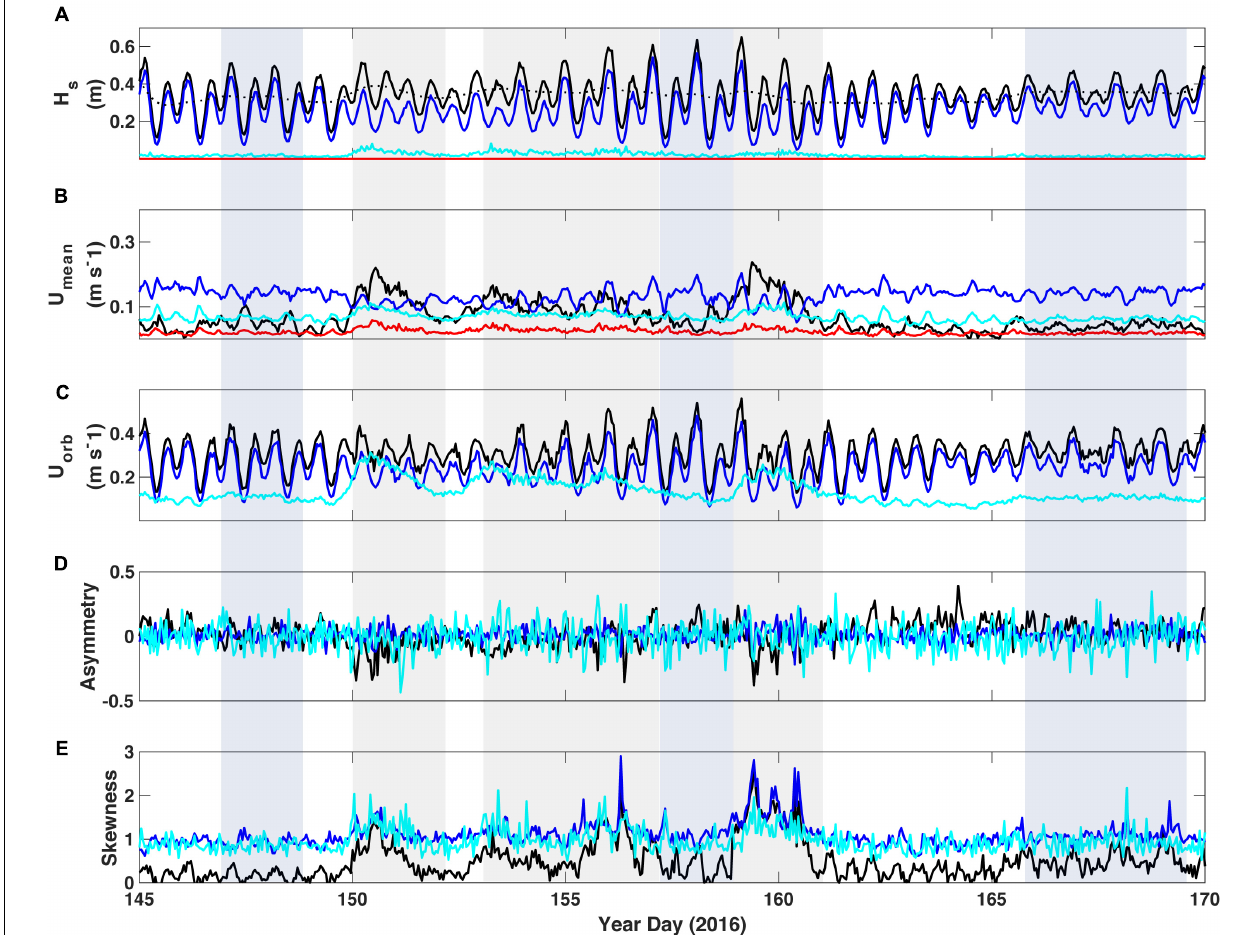
FIGURE 3 | Wave and current parameters delineated by spectral bandwidth at TR1 on the outer reef flat near the reef crest. (A) Significant wave height; the black dotted line denotes the 40-h low-pass filtered wave height. (B) Burst mean near-bed current speed and (C) Near-bed wave-orbital velocity from 10 cm above bottom. (D) Wave asymmetry. (E) Wave skewness. Black = unfiltered data, blue = sea-swell band, cyan = infragravity band, and red = very-low frequency band. Parameters were calculated from hour-long bursts of continuous data; mean current speed of unfiltered data was derived from the vector sum of the burst mean U and V. Energy in the VLF band was significantly lower, if not zero, and is therefore not plotted in U orb , asymmetry or